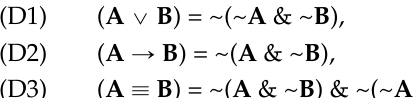
Symbol 1 stands for arbitrary chosen tautology of propositional